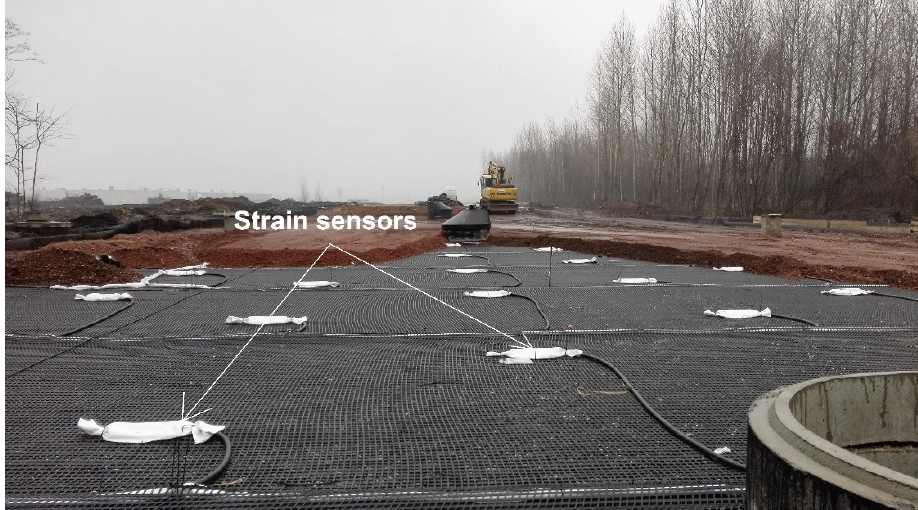
Figure 4. Second monitoring layer, measurement of elongation in geosynthetic reinforcement—Ruda Ś l ą ska, N–S route, Poland 2018 (example of monitoring application).